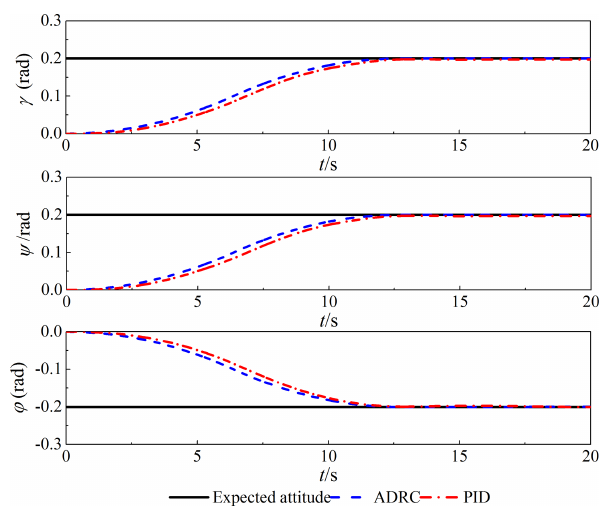
Figure 9. Angular-velocity estimation.